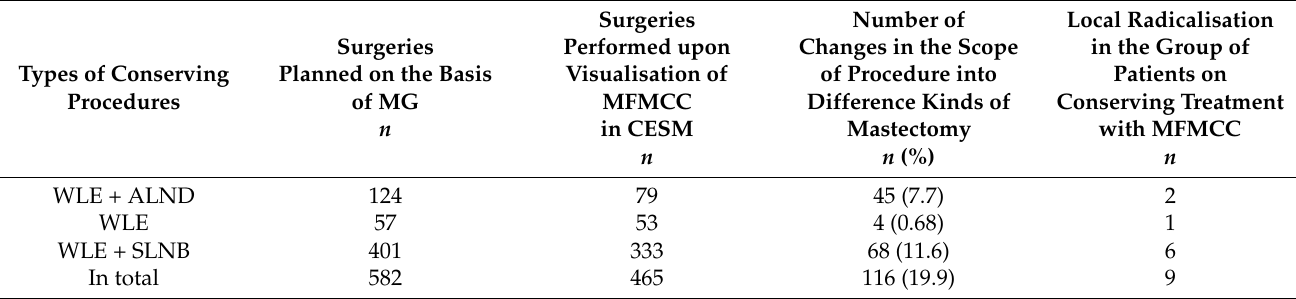
Table 5. A change in the scope of procedures upon identification of multifocal-multicentric breast cancers (MFMCC) in